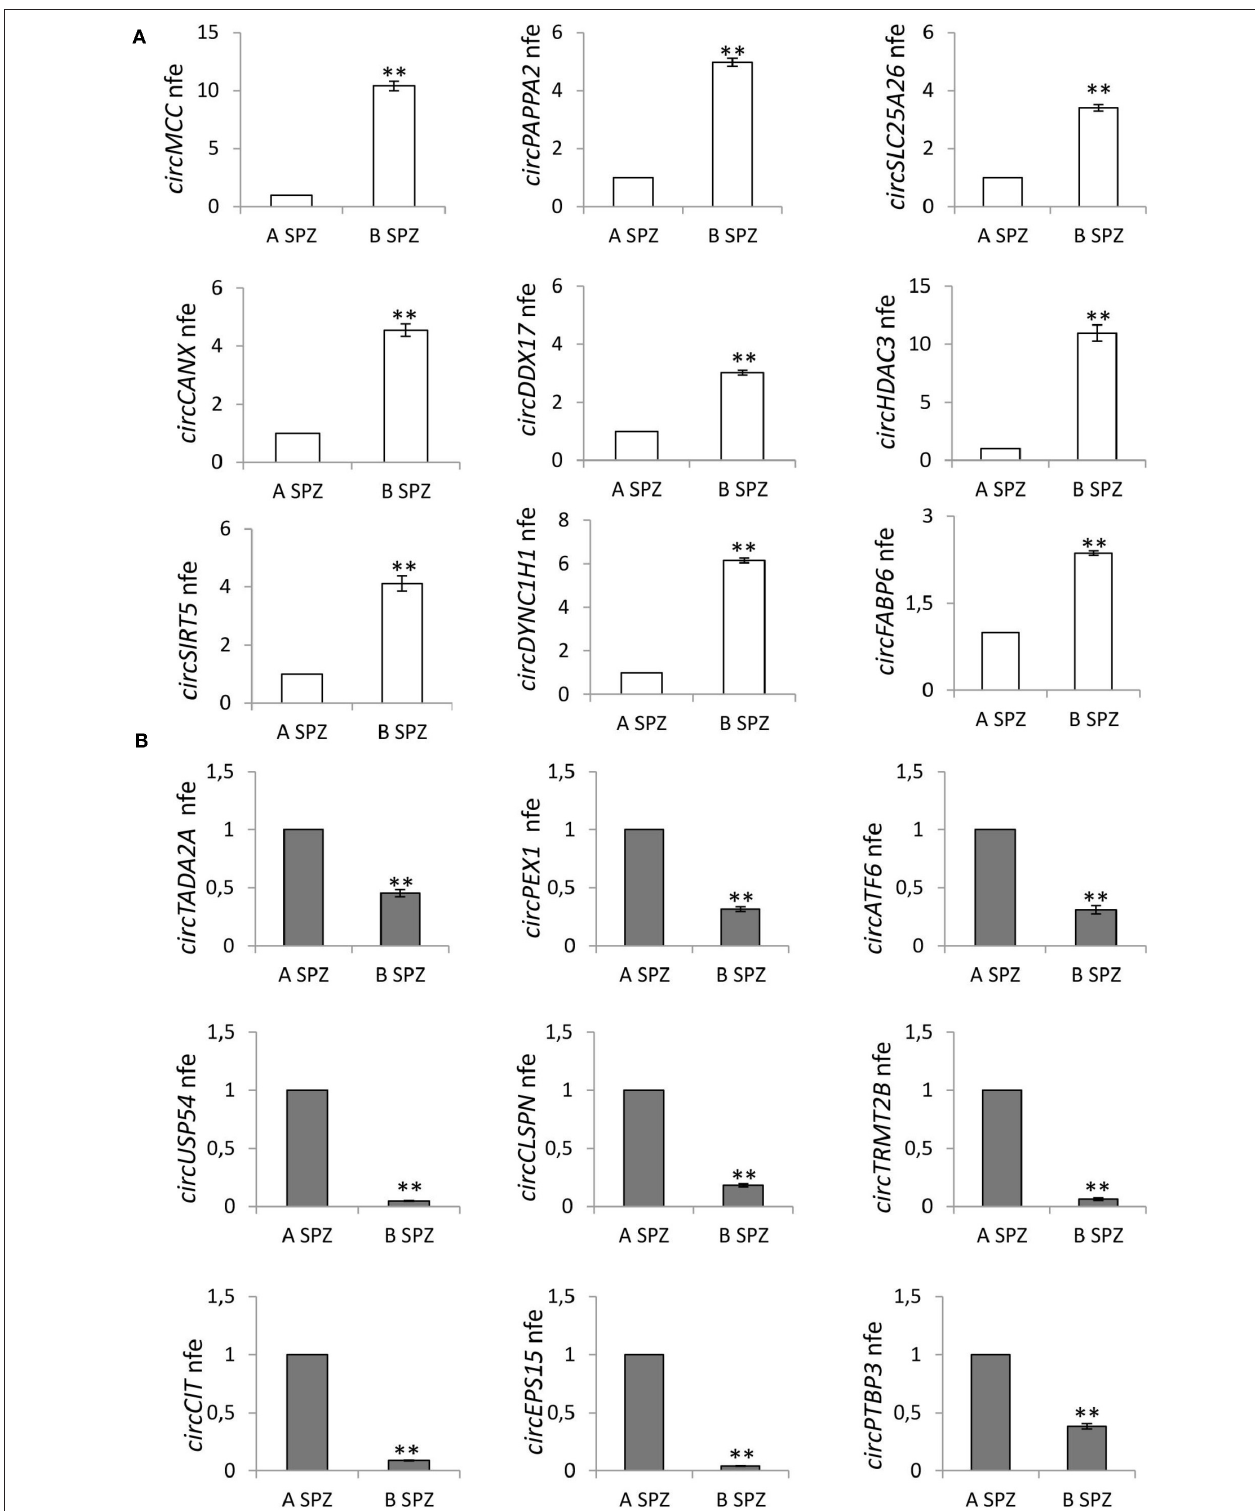
FIGURE 4 | (A) Validation of the circRNA-microarray results up-regulated in B compared to A asthenozoospermic derived SPZ; ** p < 0.01. (B) Validation of the circRNA microarray results down-regulated in B compared to A asthenozoospermic derived SPZ; ** p < 0.01. A significant high score of normalized intensity and related host genes involved in sperm physiology and embryonic development functions represent the “selection criterion” of the DE-circRNAs validated.